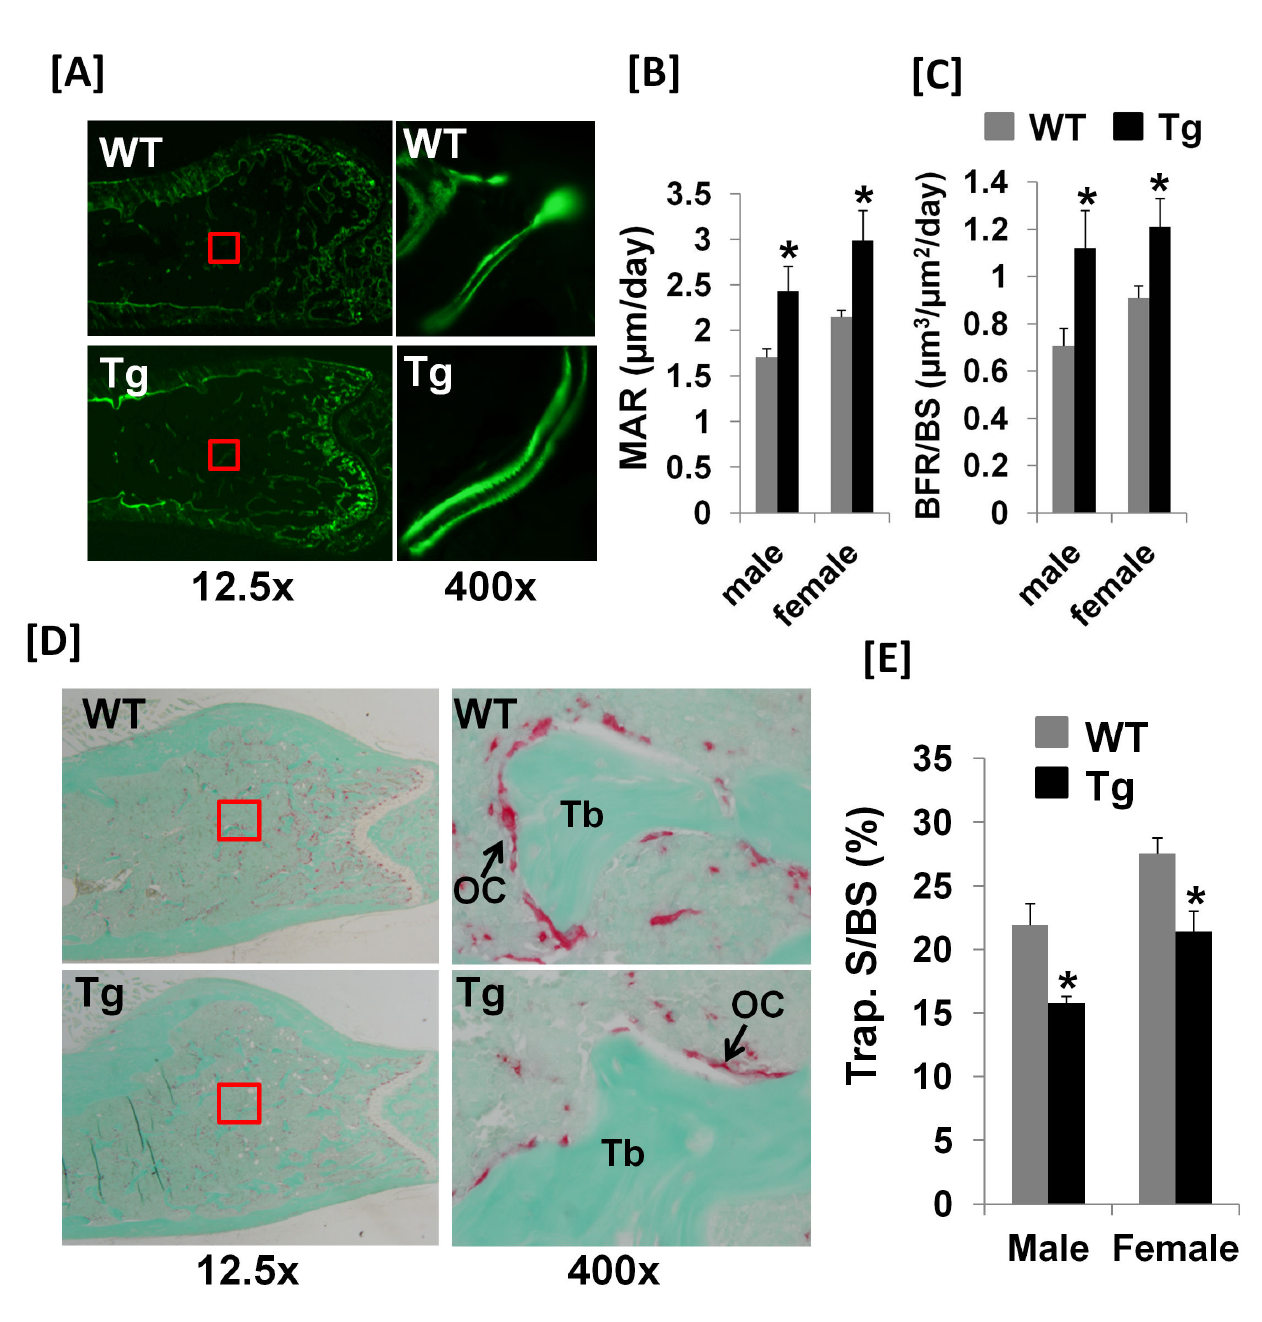
Figure 3. Col3.6-Tg efnb1 mice exhibit increased bone formation and reduced bone resorption. [A] Images of calcein double labeling of the distal metaphysic femurs of 10 week old WT and Tg mice. Mineral apposition rate (MAR) [B] and bone formation rate (BFR) [C] measured at the second spongiosa of the distal femural metaphysis of 10 week old WT and Tg mice. Data are means ± SEM for N = 7. [D] Images of TRAP staining of the distal femural metaphysis of 10 week old WT and Tg mice. [E] Quantitative data of the TRAP labeled surface to bone surface (Trap. S/BS) measured at the secondary spongiosia of the distal femural metaphysis of 10 week old mice. Data are means ± SEM for N = 8. A star represents statistical significance (P < 0.05) when compared to WT littermate controls.